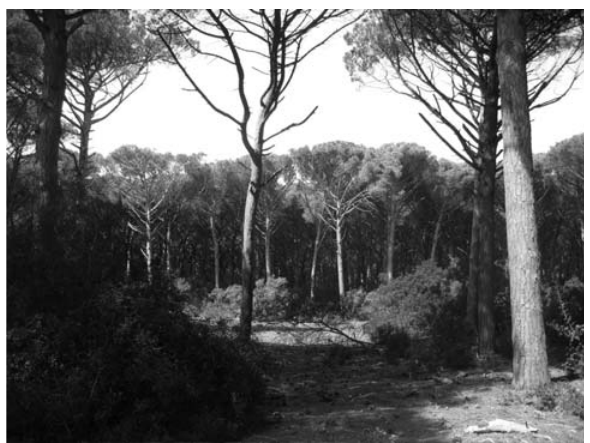
Fig. 2. Italian stone pine forms closed canopy